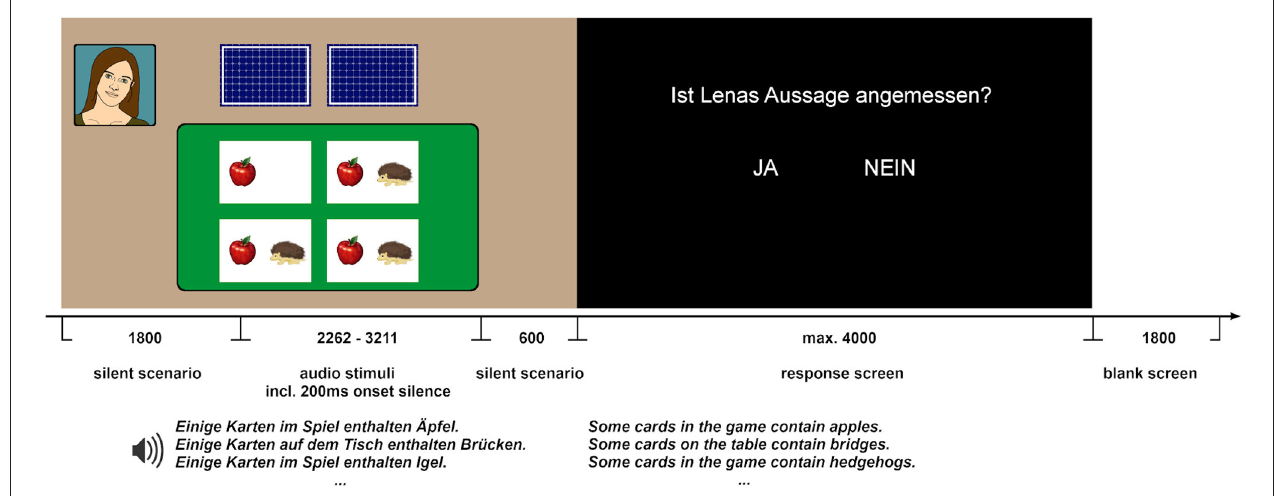
FIGURE 1 | The structure of a trial: The picture was presented 1,800 ms before the onset of the audio and until 600 ms after the audio offset. The audio files varied in length (range: 2,262–3,211 ms, the average duration of Table-sentences was 2,800 ms and the average duration of Game-sentences was 2,603 ms) and contained approximately 200 ms of an initial silence for a more natural sound onset. The onset of the critical word was between 1,857 and 2,664 ms after the onset of the audio, the average onset was 2,139 ms. Subsequently, a screen with the assignment of the buttons was presented (left vs. right hand is counterbalanced). For a given scene, the condition was dependent on the specific sentence played, as explained in Table 1 . TABLE 1 | Experimental conditions for the example scene in Figure 1 .